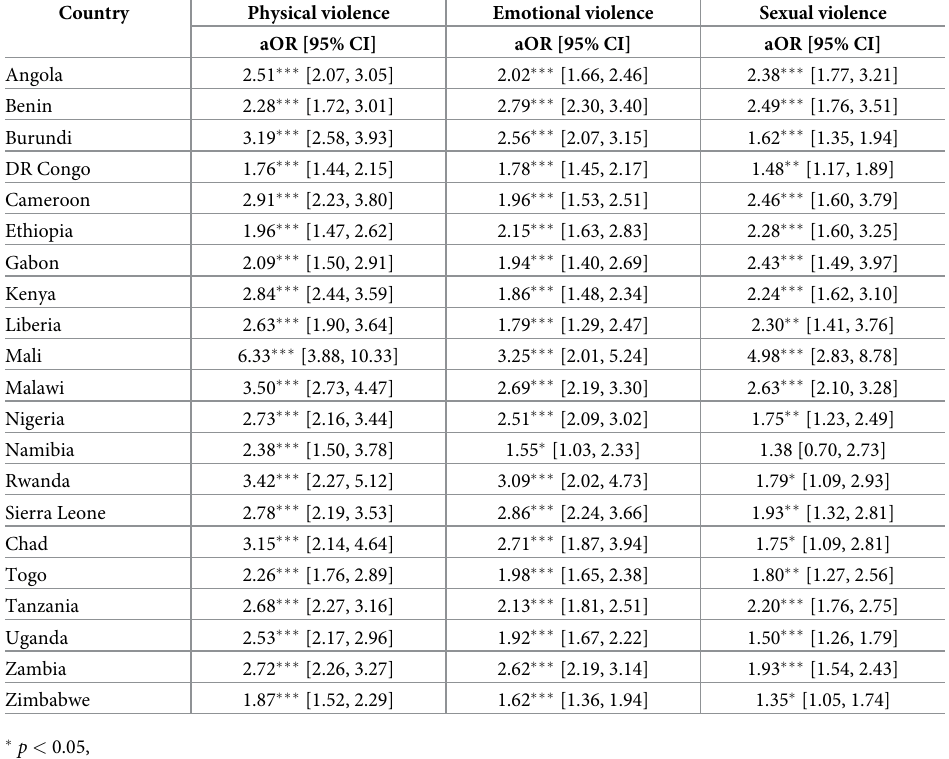
Table 5. Association between partner alcohol consumption and intimate partner violence among women in sub- Saharan Africa segregated by